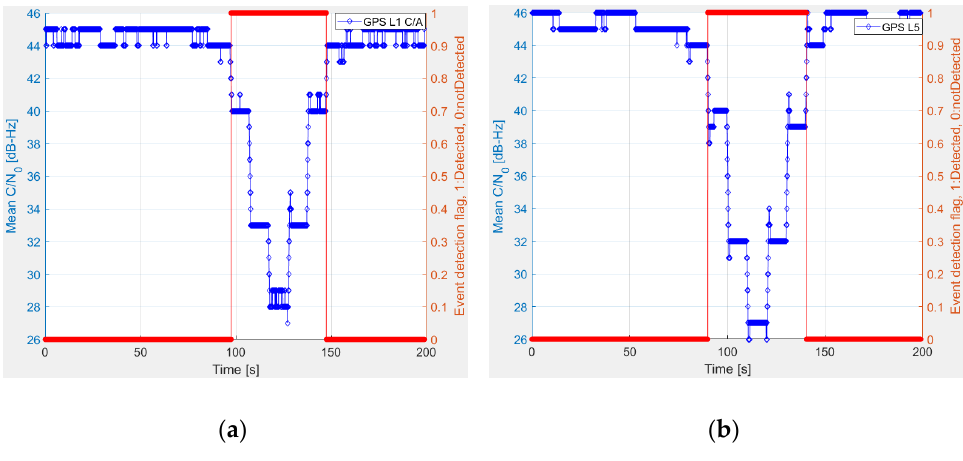
Figure 1. Jamming event detection for ( a ) GPS L1 C/A and ( b ) GPS L5. The outcome of the jamming event detector is summarized in Table 1. Jamming events are identified on the lower and upper L-bands for about 51 s on both occasions. Table 1. Jamming event detection on different GNSS signals.